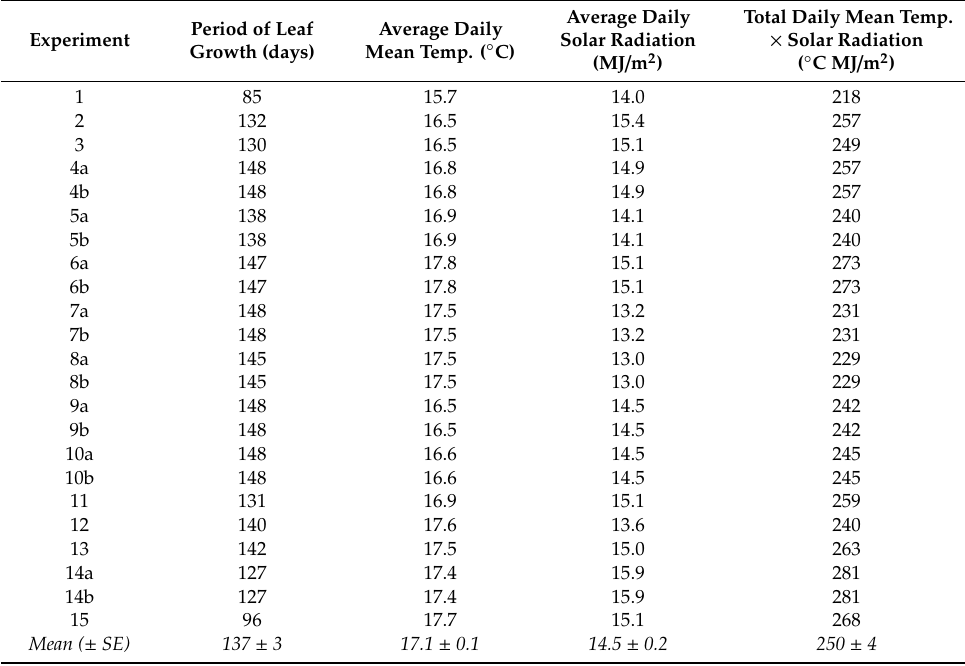
Table 2. Temperatures and solar radiation in the experiments with the strawberries in Queensland. Details of the experiments are provided in Table